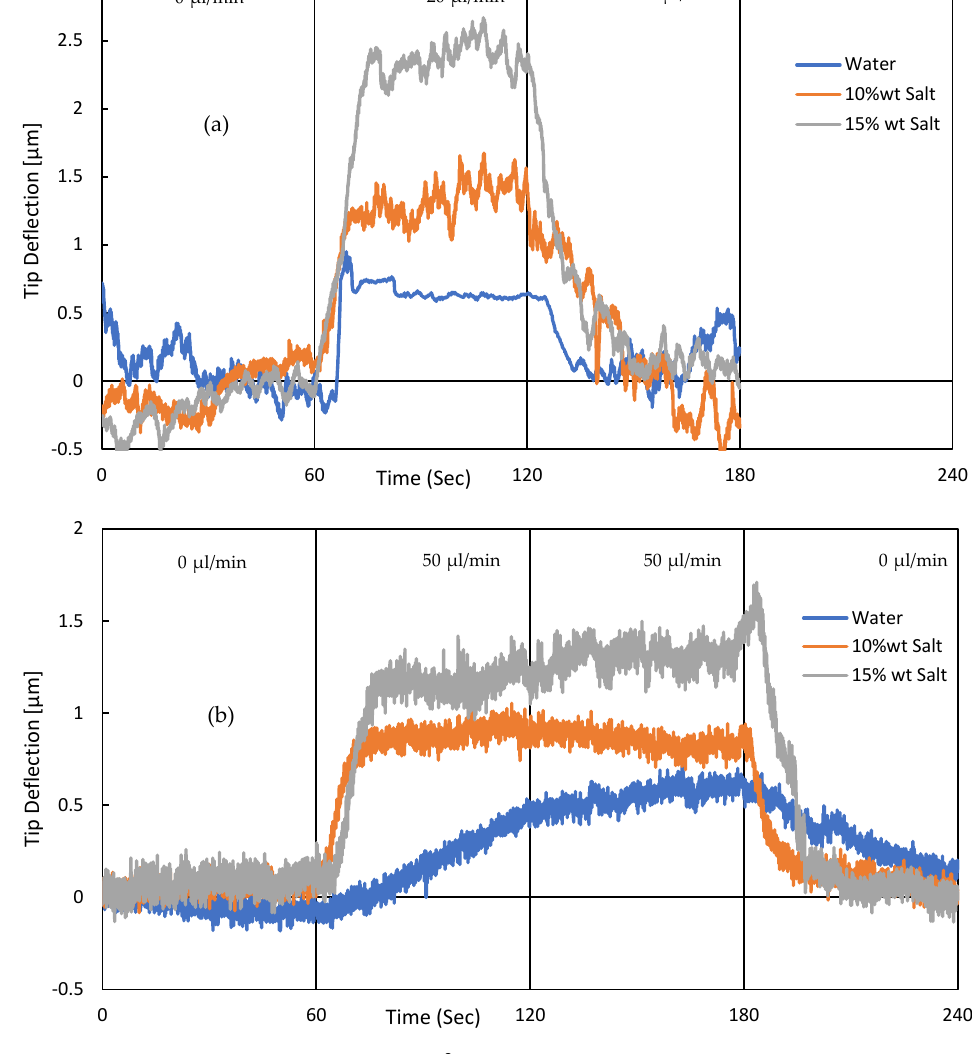
Figure 15. Sensitivity experiment of SPMF 3 to various fluid properties. A water and salt mixture with different salt concentrations has been used here. ( a ) The SPMF 3 sample has a microchannel of 400 × 100 µ m 2 (width and depth). ( b ) The SPMF 3 sample has a microchannel of 200 × 100 µ m 2